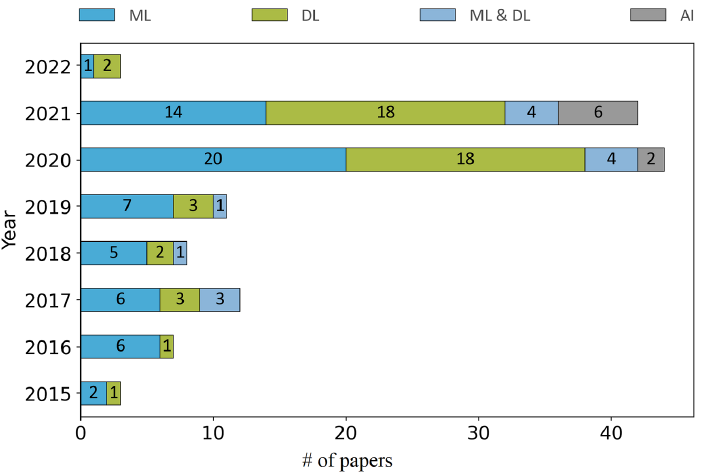
Figure 11. Included papers per year are distributed in four categories based on the used computa- tional techniques, i.e., ML, DL, ML and DL and AI.